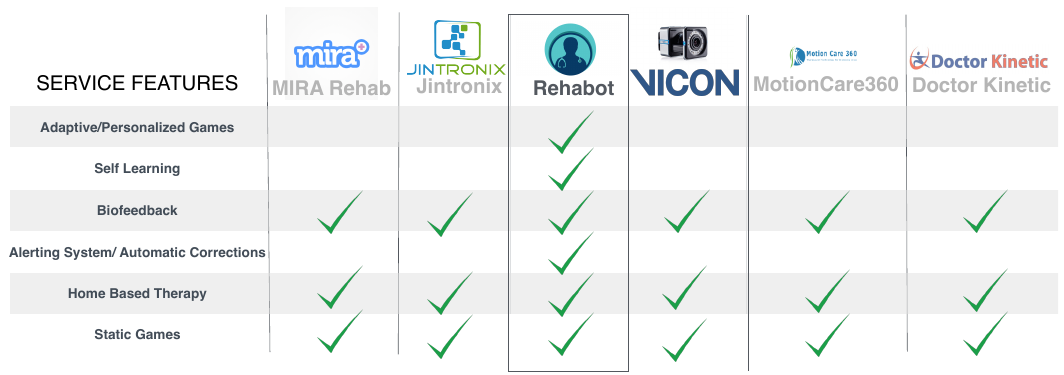
Figure 2. Evaluation of the closest related works in